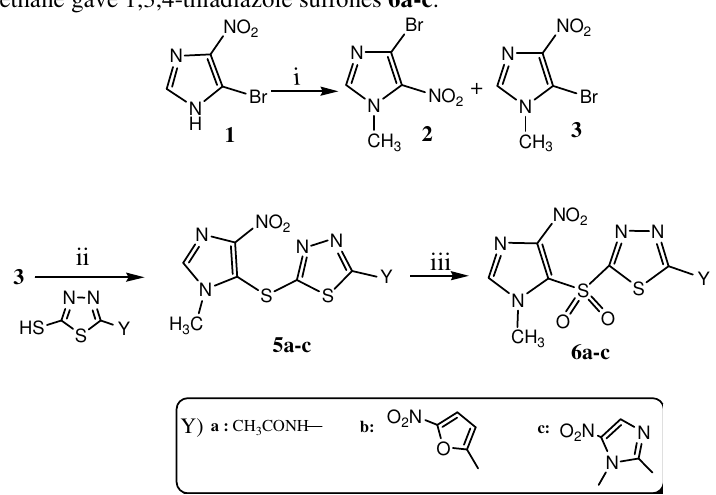
Figure 1 . Structure of 5-substituend 1-methyl-4-nitro-1 H -imidazoles ( 6a-c) reagent and condition: (i) CH N , dry ether; (ii) KOH, EtOH, reflux (iii) m -CPBA, CH 2 2